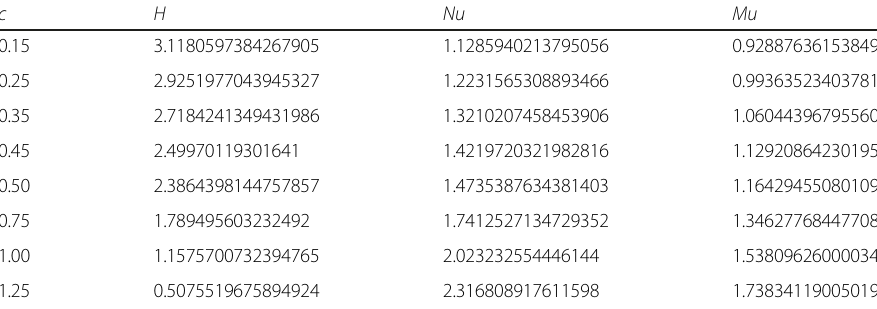
Table 7 Values of skin friction ( H ), Nusselt number ( Nu ), and Sherwood number ( Mu ) for different values of